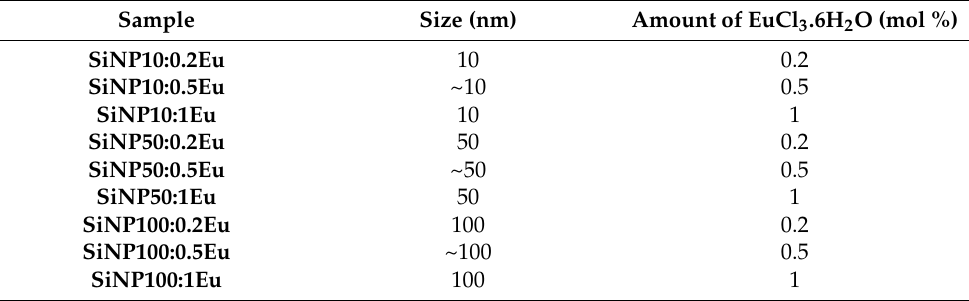
Table 1. Starting compositions and nomenclatures of europium-doped silica